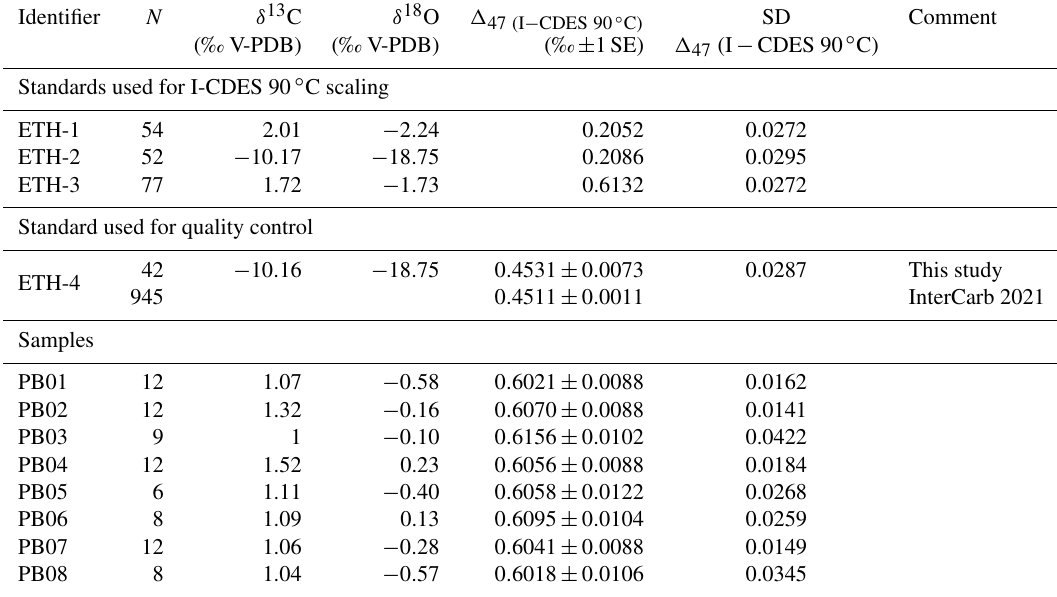
Table 2. Clumped-isotope results. ETH-1, 2, and 3 define the I-CDES 90 ◦ C framework. Hence their (cid:49) 47 are identical to the values reported by Bernasconi et al. (2021). The ETH-4 standard is used for monitoring measurement accuracy. The availability of sample material allowed for 6 to 12 repeated measurements ( ∼ 500µg each). The standard error on sample measurements is calculated using the pooled standardiza- tion method described by Daëron (2021). The δ 18 O and δ 13 C sample values reported in this table were measured simultaneously with (cid:49) 47 in the AMGC-VUB lab.